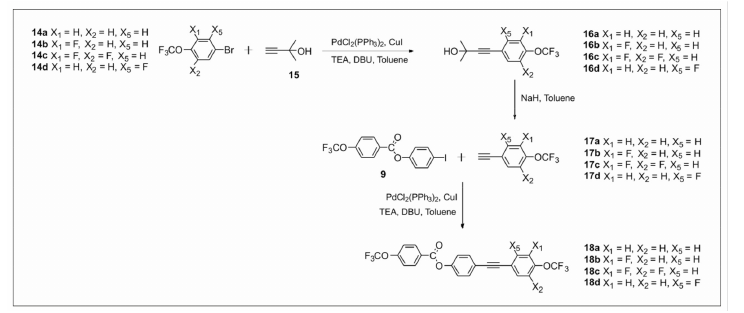
Figure 6. Synthesis of ester–tolane derivatives 18a – 18d